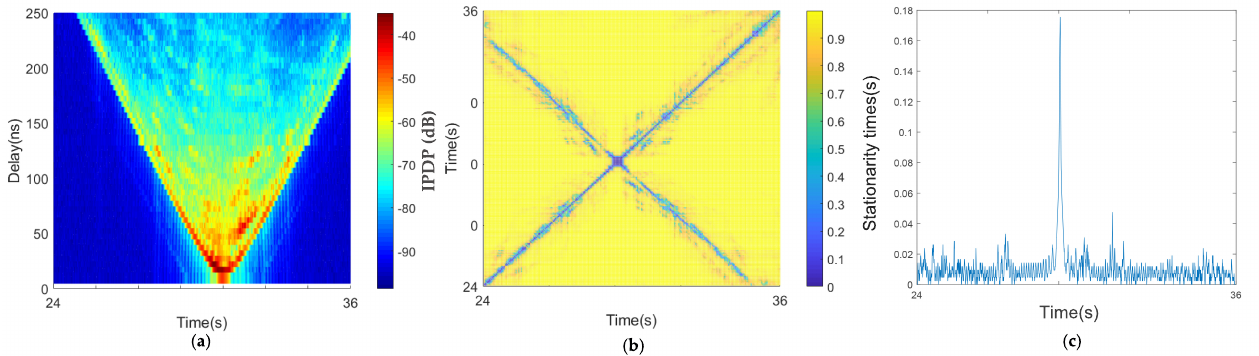
Figure 15. Results of the opposite traveling suspension bridge scenario: ( a ) average PDPs, ( b ) temporal PDP correlation coefficient, and ( c ) stationarity time